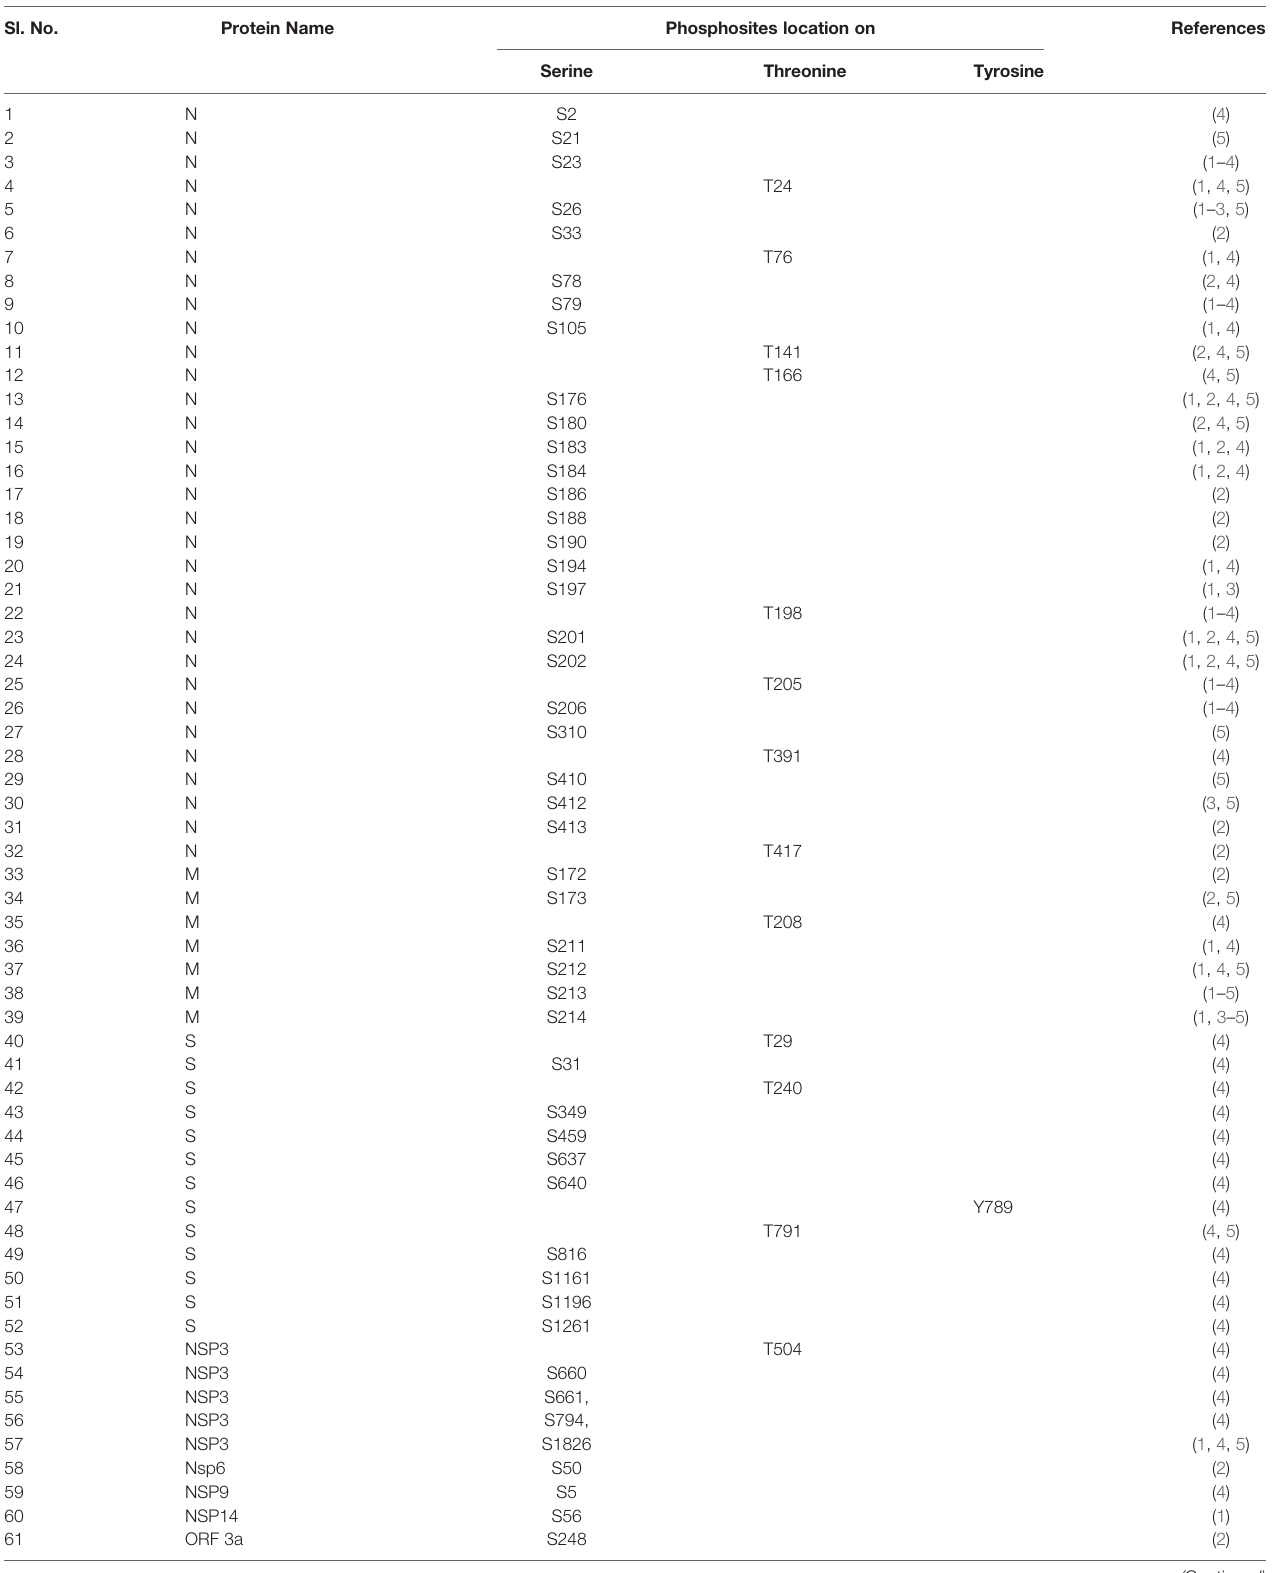
TABLE 1 | Phosphorylation sites identi fi ed in SARS-CoV-2 proteins. Sl.